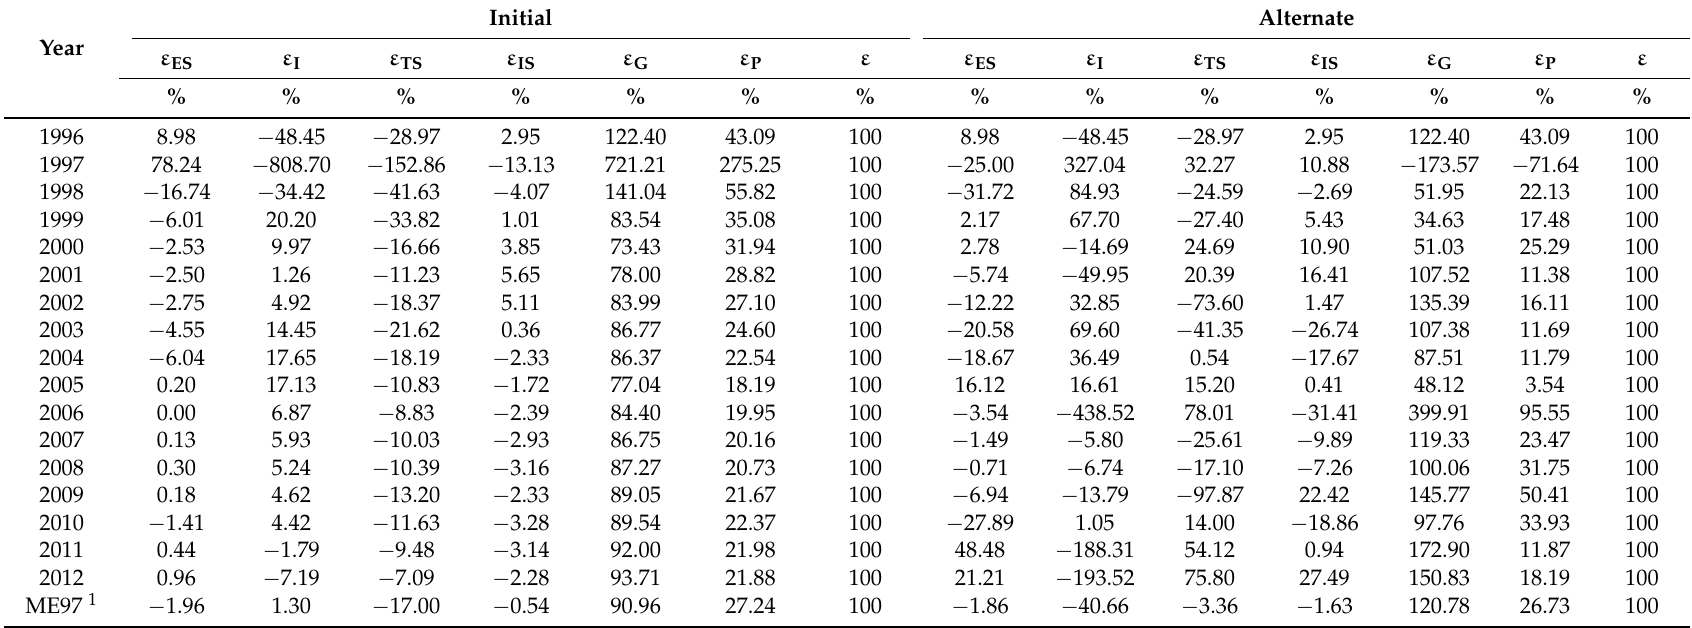
Table 2. The proportion of decomposition factors of the elasticity